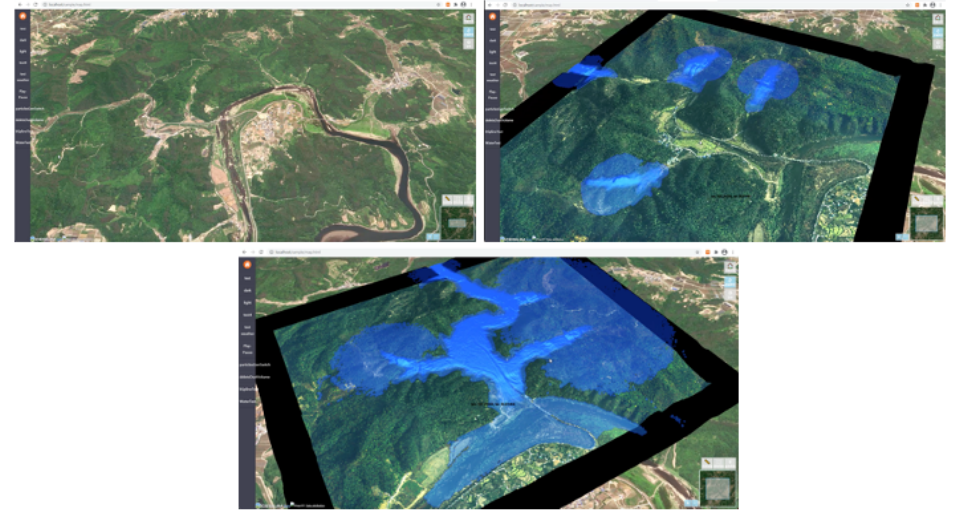
Figure 3. Hydrological water flow simulation.